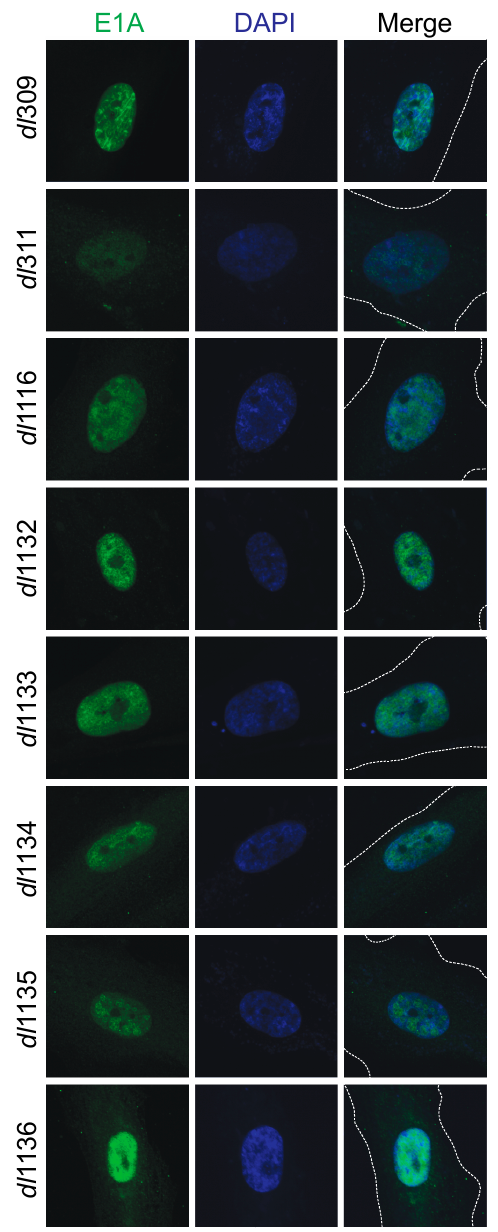
Figure 4. Sub-cellular localization of E1A and deletion mutants in infected cells. Arrested WI-38 cells were infected with the indicated mutants at a MOI of 100 for 24 h. Cells were then fixed, permeabilized and stained with anti-E1A antibody (M58) and a secondary anti-mouse AlexaFluor 488-conjugated antibody to visualize E1A. DAPI was used as a nuclear counterstain. The dashed lines in the merged image indicate cell boundaries. Images were acquired on a Zeiss LSM700 laser confocal microscope using the 63× objective lens.